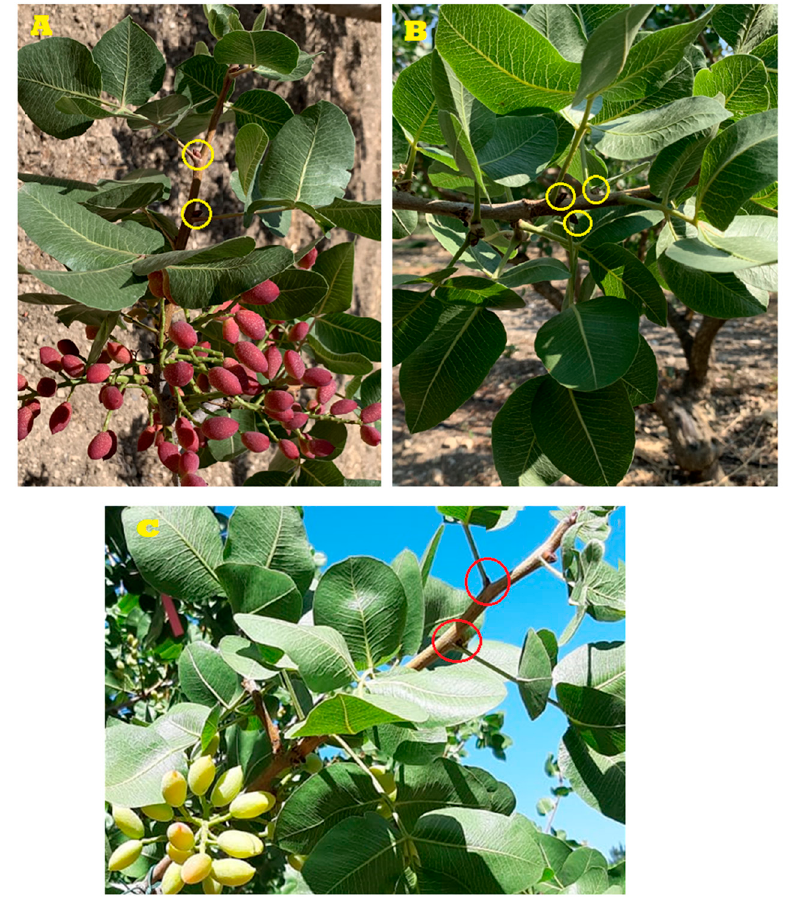
Figure 1. ( A ): Fruit clusters on one-year-old wood and lateral inflorescence buds on current year’s bearing shoot of P. vera L. indicated by yellow circles (June “ON”); ( B ): one-year-old wood and lateral inflorescence buds on current year’s not-bearing shoot (July “OFF”); ( C ): Red circles show the sites of inflorescence bud abscission in current year’s bearing shoot (July “ON”).